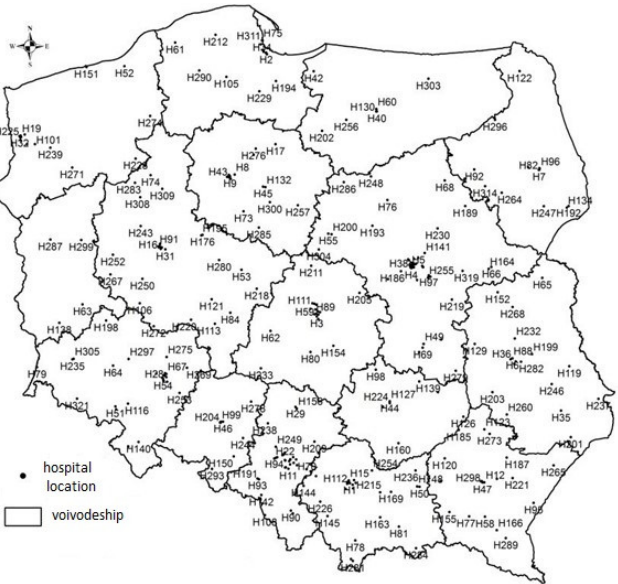
Figure 1. Location of the analyzed public hospitals. Note: H, conventional symbol of the hospital adopted for the purpose of the study.